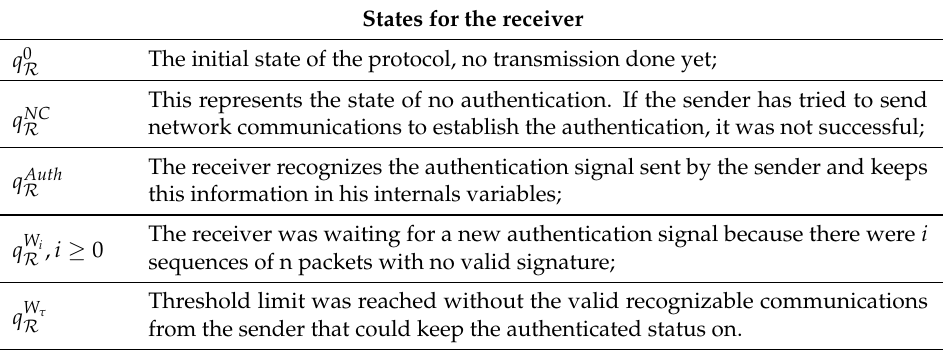
; and ( b ) the receiver responds to the sender after he gets the sender S